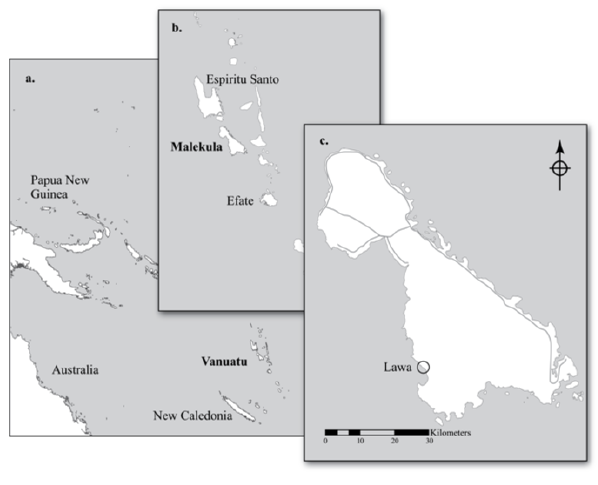
Fig. 1 . Map of case study sites: (a) Southwest Pacific, showing Vanuatu; (b) Vanuatu, showing Malekula Island; (c) Malekula, showing Lawa